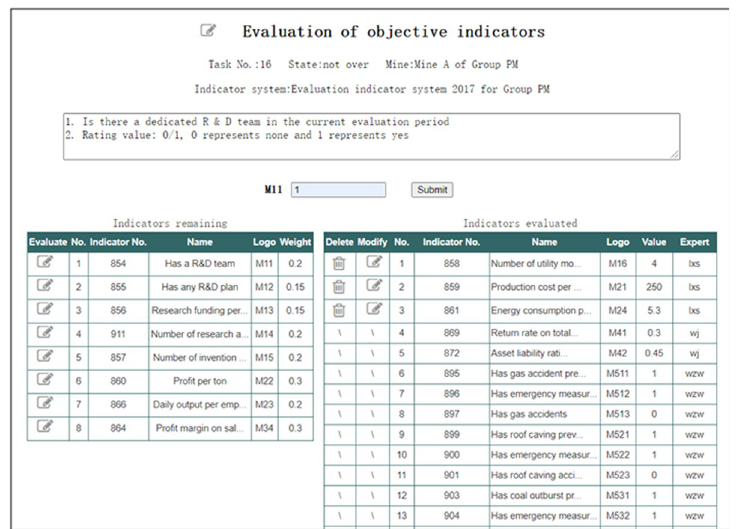
Fig 13. Evaluation of final-level objectvie